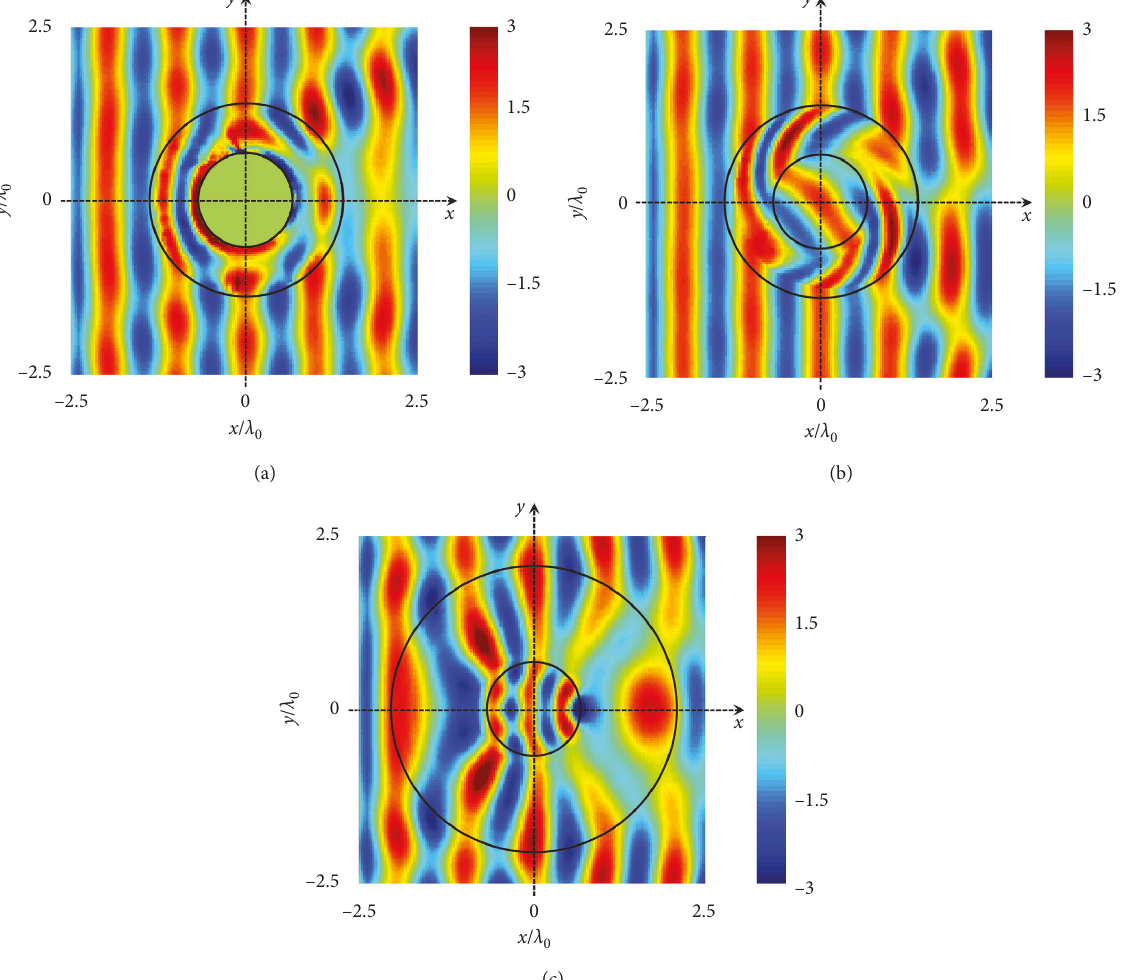
Figure 13: FDTD snapshots with boundary abrasion with the use of linear functions: (a) the cloak, (b) the rotator, and (c) the concentrator. The MTMs lost their functionality.